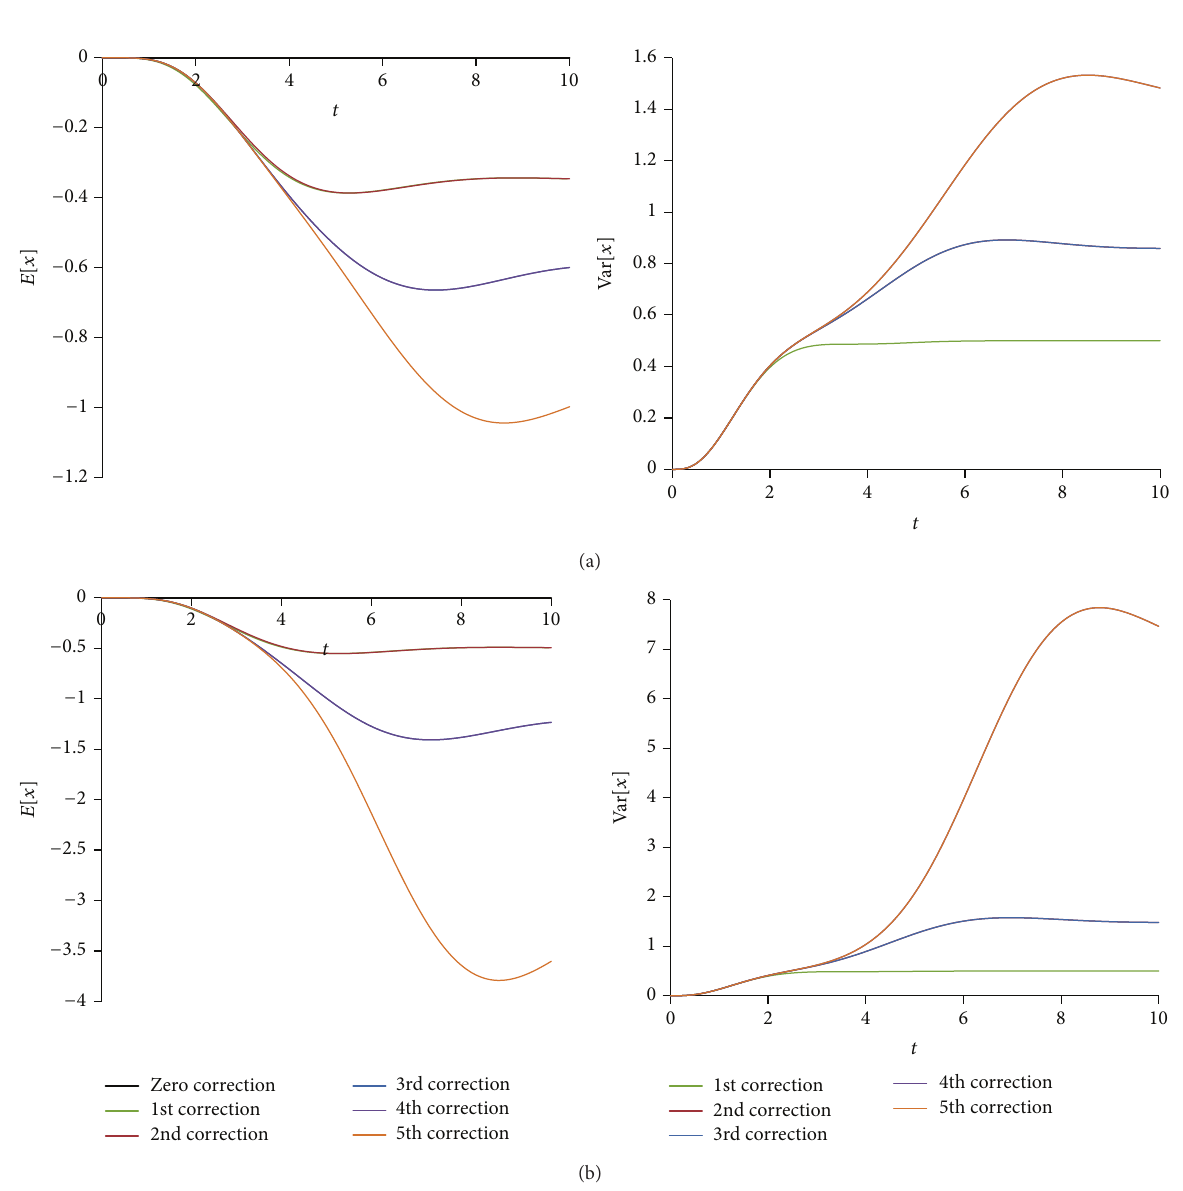
Figure 4: First-order response mean and variance for (a) 𝜀 = 0.7 and (b) 𝜀 = 1.0